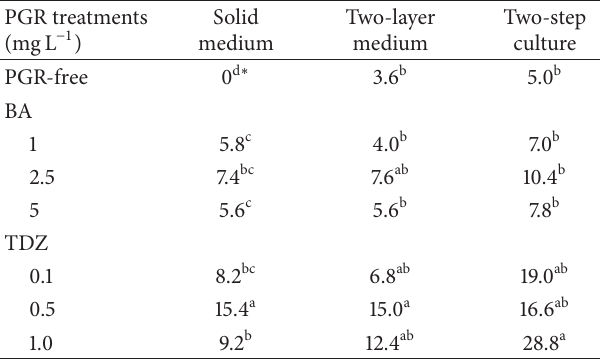
Table4:Numberofembryosformedontheleafsurfaceof4-month- old seedlings, depending on culture systems and concentration of